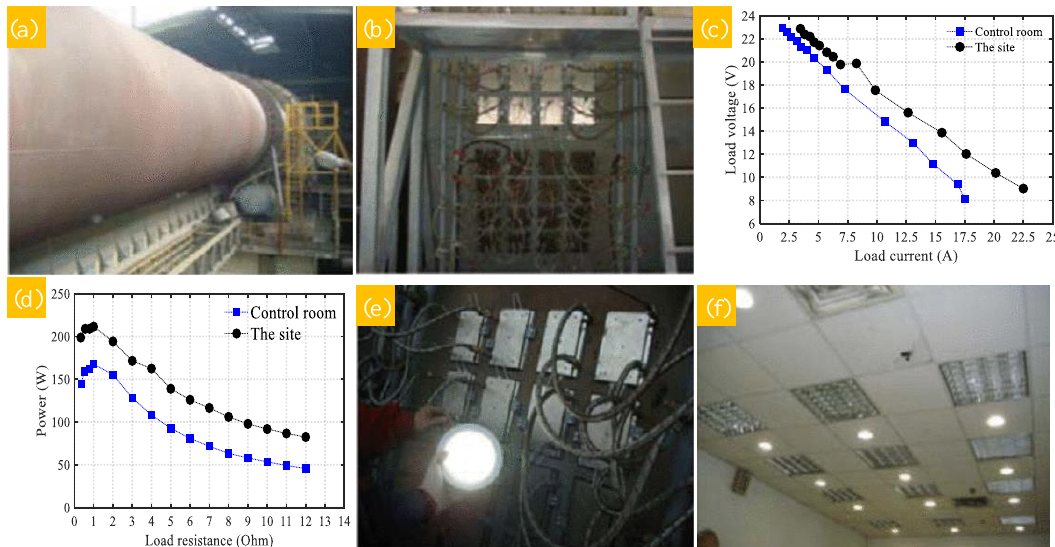
Figure 12. ( a ) working cement kiln, outer diameter: 4.8 m and length:76 m (adapted from [98] with permission), ( b ) thermoelectric power generation system containing 32 thermoelectric power generation units installed on a 2 × 1 m 2 steel frame (adapted from [98] with permission), ( c ) output voltage as a function of current (adapted from [98] with permission), ( d ) power output as a function of load resistance (adapted from [98] with permission), ( e ) generated power with a matched load power of 214.3 W at the site (adapted from [98] with permission), and ( f ) generated power with a matched load power of 214.3 W in the control room to light up the indoor LED lamps (15 LED lamps × 10 W) (adapted from [98] with permission).